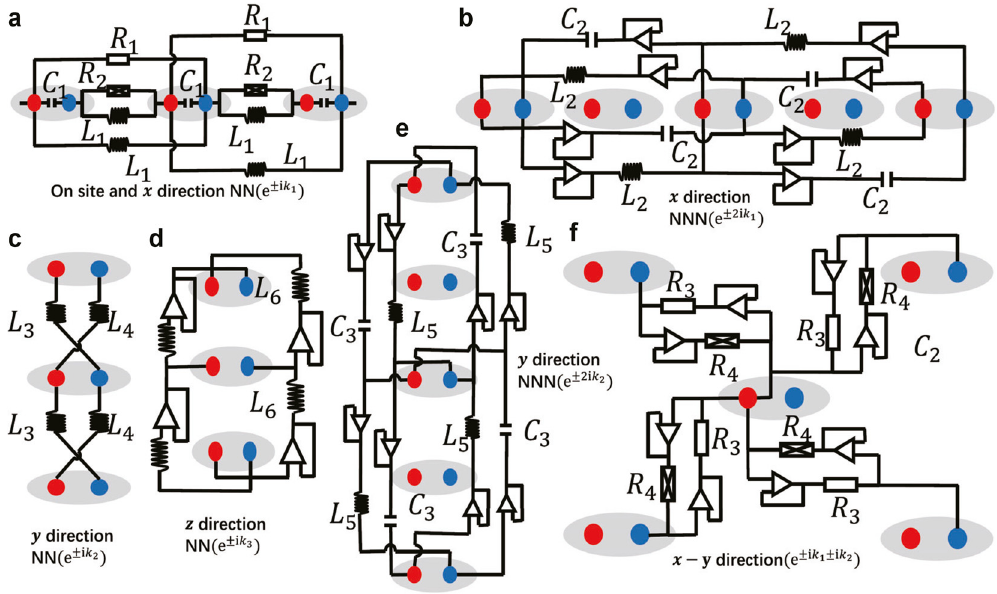
Figure 11: Illustration of different constituents of the non-Hermitian trefoil knot circuit. (a) On-site hopping and nearest-neighbor hopping along the x direction, (b) next-nearest-neighbor hopping along the x direction, (c) nearest-neighbor hopping along the y direction, (d) nearest-neighbor hopping along the z direction, (e) next-nearest-neighbor hopping along the y direction, and (f) diagonal hopping within the x – y plane. Reproduced with permission from Reference [179]. Copyright 2021, Nature Portfolio